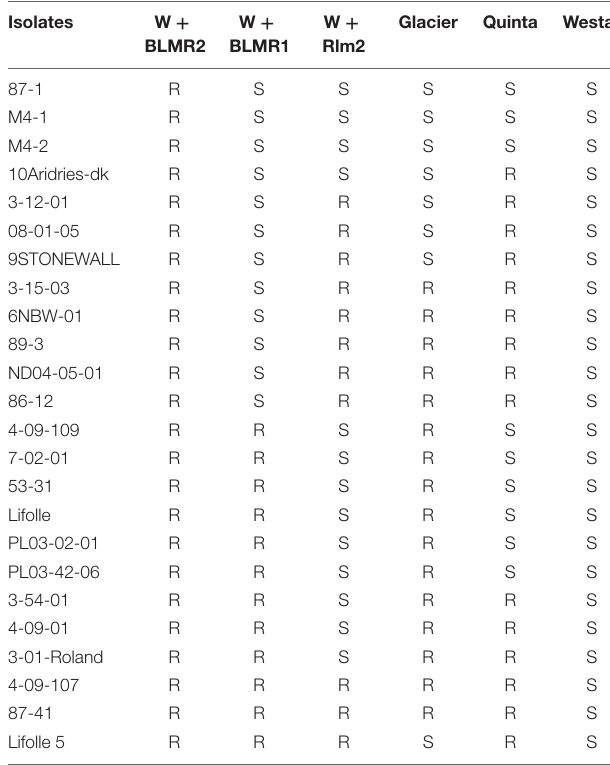
*All isolates from the collection of University of Manitoba. Three near isogenic lines W + BLMR1, W + BLMR2, W + Rlm2, two resistant cultivars Glacier and Quinta, and susceptible cultivar Westar; R representing 0–4 ratings, S representing 5– 9